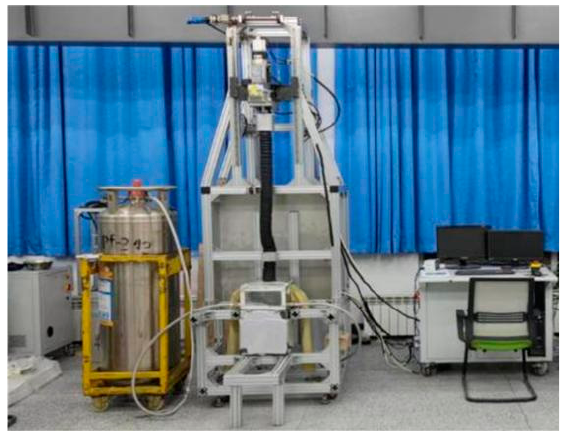
Figure 4. Experimental apparatus.